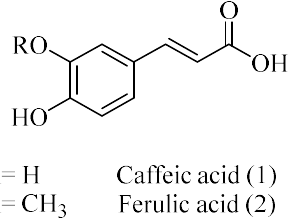
Figure 1. Structure of Caffeic acid and Ferulic acid .